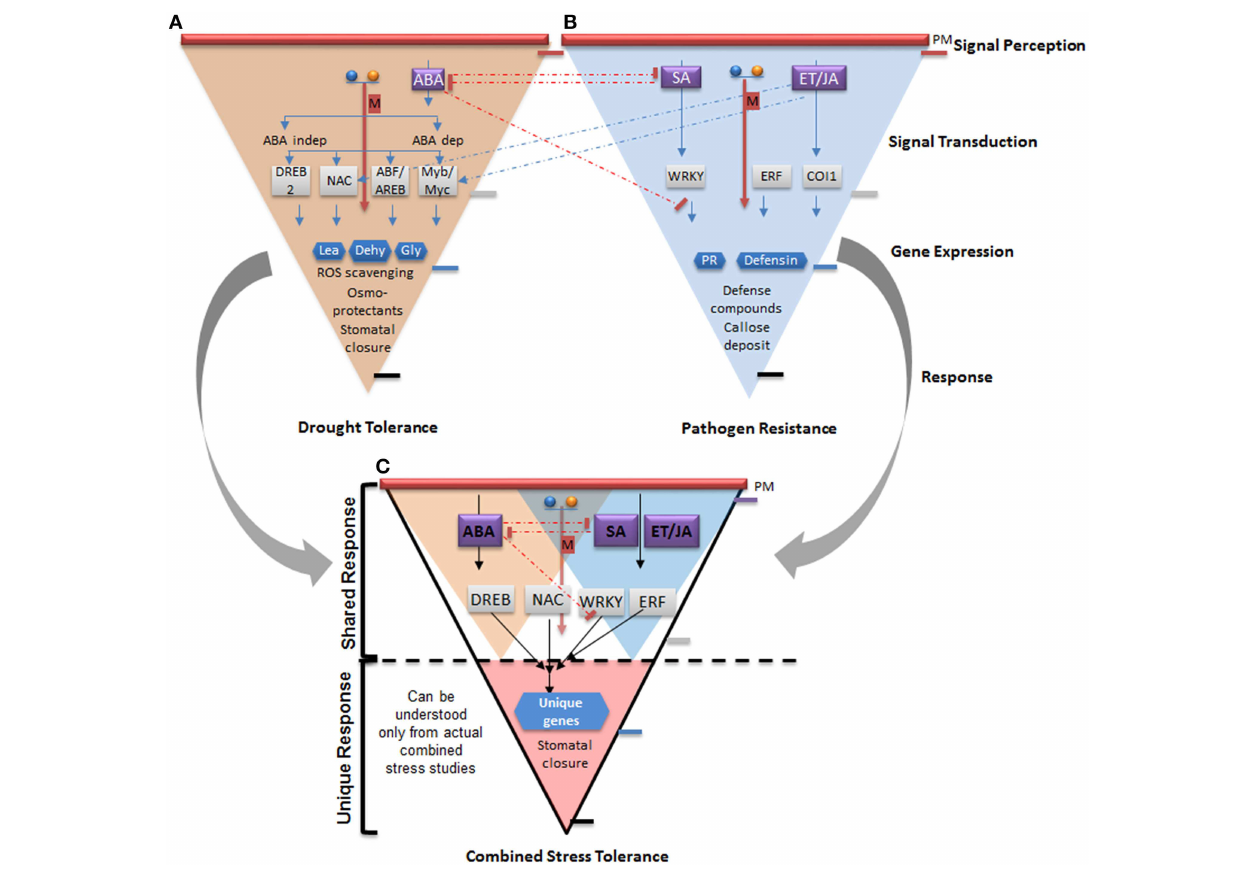
FIGURE 3 | Model representing cross talk between drought and pathogen stress signaling pathway from individual stress studies and its relation to shared and unique response pathway provoked under combined stress. The two inverted triangles in the upper panel represents the drought stress (A) and biotic stress signaling pathway (B) consisting of signal perception, signal transduction, gene expression and response generation steps with the representative gene products. The inverted shape represents the general response (wide upper side) at the stress perception and signal transduction stage culminating to a specific response (tapering lower end) contributing to tolerance to a particular stress. The response of the plants to combined drought and pathogen stress consist of both the shared (responses common to drought and pathogen stress) and unique responses as represented by the triangle (C) . The overall response of plants to the combined stress is governed by the key players involving ROS, Ca 2 + , MAPKs, and the different transcription factors as well as some unique genes regulating the tailored responses. The shared responses can be deciphered by understanding the cross talk between the drought and the pathogen stress tolerance signaling networks whereas dedicated studies are required to understand the unique responses. The yellow colored small triangle represents the responses shared between drought and combined stress whereas the blue triangle represents the responses shared between pathogen and combined stress. The overlapping area between the two small triangles represents the responses shared by the drought and pathogen stress. The red colored triangle at the apex represents the unique response under the combined stress. The blue and yellow color spheres represent the calcium and ROS molecules. The red color arrow represents the MAPK pathway. The dashed arrows indicate the cross talk wherein the red colored dashed arrows represent the suppression and blue dashed arrows represent the activation of the respective stress responsive genes. PM, plasma membrane; ABA, abscisic acid; SA, salicylic acid; JA, jasmonic acid; ET, ethylene; M, MAPK pathway; ABA dep, ABA dependent pathway; ABA indep, ABA independent pathway; DREB, dehydration responsive element binding; NAC, NAM-ATAF and CUC 6 transcription factor; ABF, ABA binding factor; AREB, ABA responsive element binding; Myb, myeloblastosis; Myc, myelocytomatosis; ERF, ethylene responsive factor; WRKY stands for the first